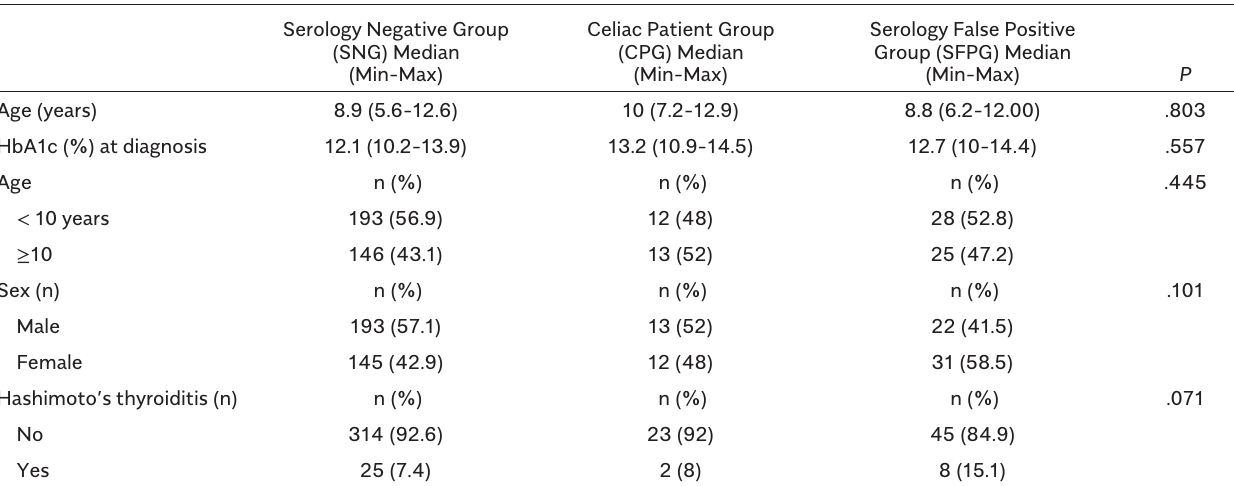
Table 1. Comparison of the Characteristics of the Patient Groups